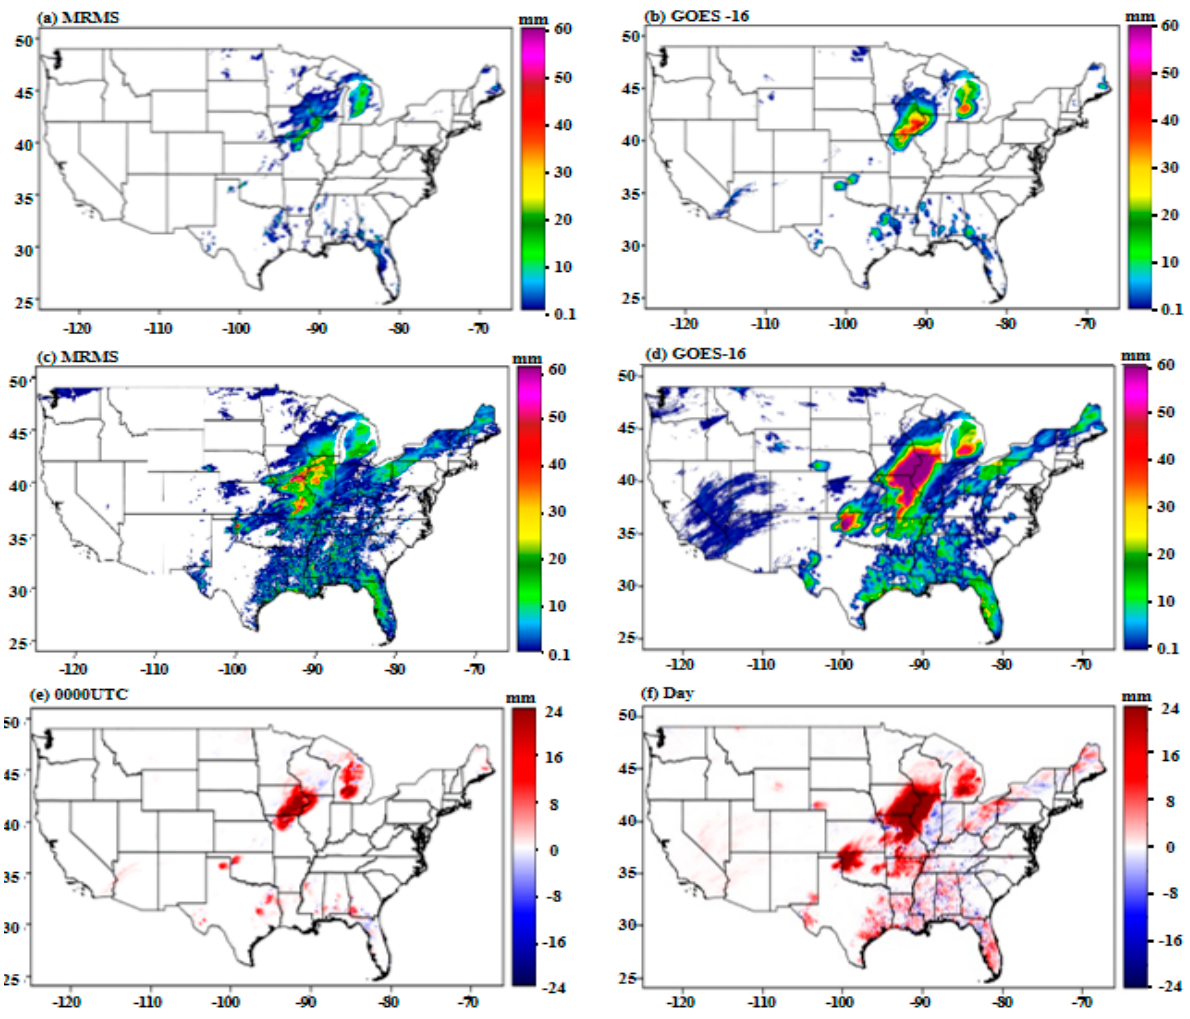
Figure 10. Rainfall accumulations from GC-MRMS and GOES-16 QPE for the 29 August 2018 event. From left to right: GC-MRMS and GOES-16 QPE; ( a , b ) are hourly precipitation accumulations at 0000 UTC; ( c , d ) are daily rainfall accumulations; and ( e , f ) are the differences between the GOES-16 QPE and GC-MRMS for hourly and daily rainfall accumulations.